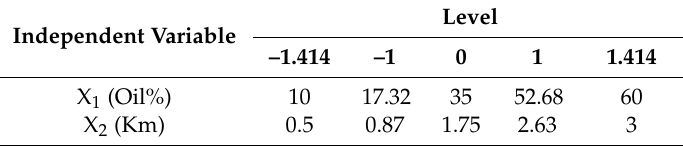
Table 1. Factor level and the correspondent values of central composite